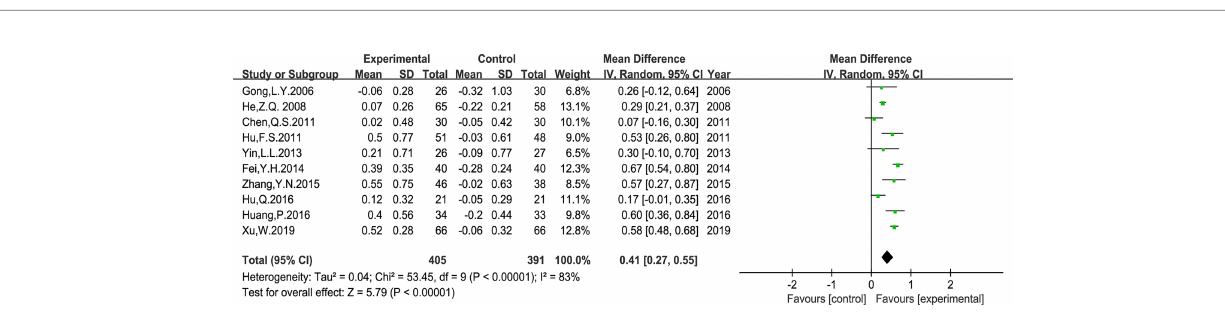
FIGURE 9 | Meta-analysis results of CD4 + /CD8 + T cells ratio between the two groups.